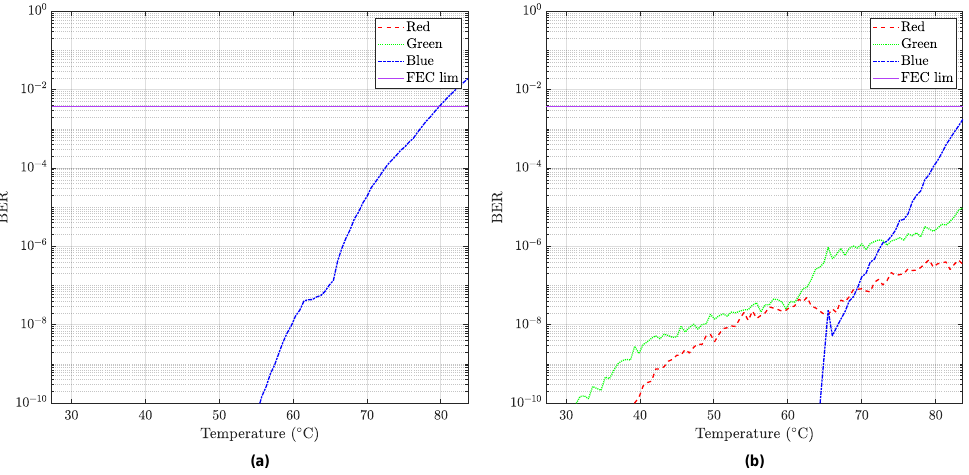
Figure 9. Bit error rate (BER) at different temperatures, compensating the channel using the CSI corresponding to 27°C and with a high SNR value (30 dB). ( a ) Sony IMX249 and ( b ) Foveon X3. Dashed line, dotted line, and dash-dot line correspond to red, green, and blue, respectively.